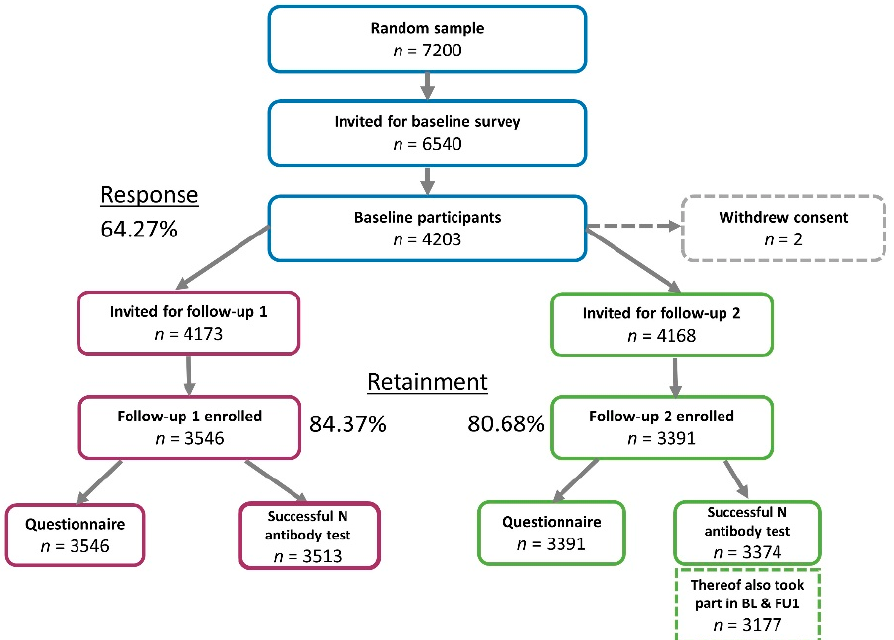
Figure 1. Summary of the TiCoKo longitudinal study design—follow-up 1 and follow-up 2. Shown are the numbers of invited individuals (14 years and older), follow-up participants, information via questionnaire, successful blood-draws and available N-test measurement for follow-up 1 and 2, respectively.